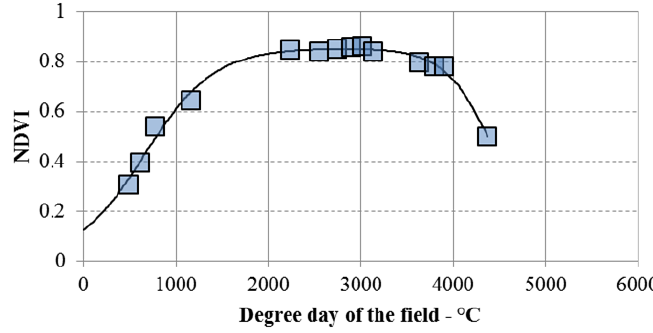
Figure 4. Measured (symbols) and interpolated (lines) NDVI values in a field.